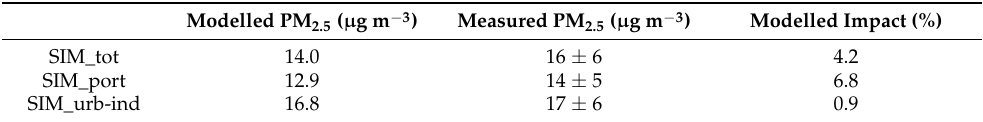
Table 7. ADMS-Urban modelled and measured averaged PM 2.5 concentrations ( µ g m − 3 ) at sampling site (ASI) position, and modelled impact of ship emissions